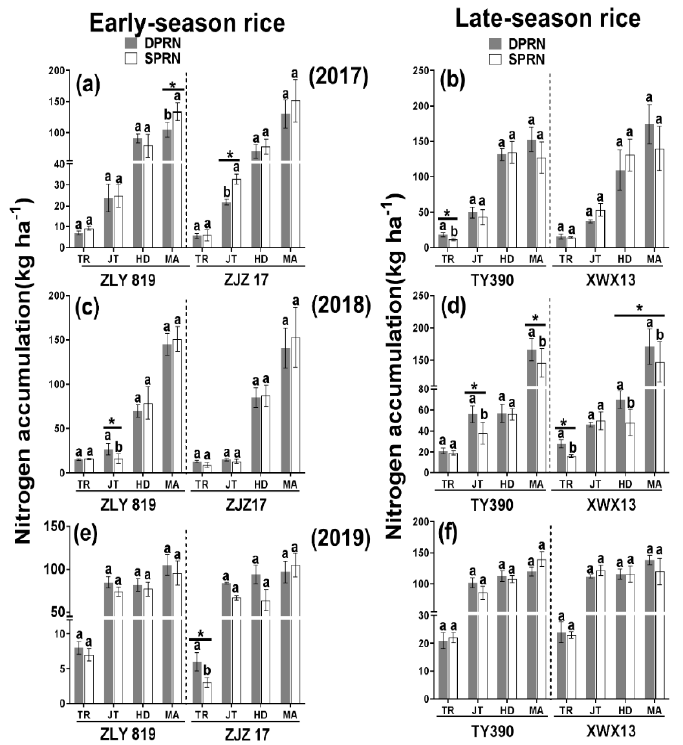
Figure 6. Nitrogen accumulation of double-cropped rice under different treatments from 2017 to 2019. Data points represent treatment means ( n = 3), and different letters indicate significant differences (* p < 0.05). DPRN represents dense planting with a reduced nitrogen rate; SPHN represents sparse planting with a high nitrogen rate. ZLY 819 (hybrid rice) and ZJZ17 (conventional rice) belong to early-season rice cultivars; TY 390 (hybrid rice) and XWX 13 (conventional rice) belong to late-season rice cultivars. TR represents the tillering stage; JT represents the jointing stage; HD represents the heading stage; MA represents the maturity stage; ( a ) represents early − season rice in 2017; ( b ) represents late − season rice in 2017; ( c ) represents early − season rice in 2018; ( d ) represents late − season rice in 2018; ( e ) represents early − season rice in 2019; ( f ) represents late − season rice in 2019. Table 2. Nitrogen-use efficiency of double-cropped rice under different treatments from 2017 to